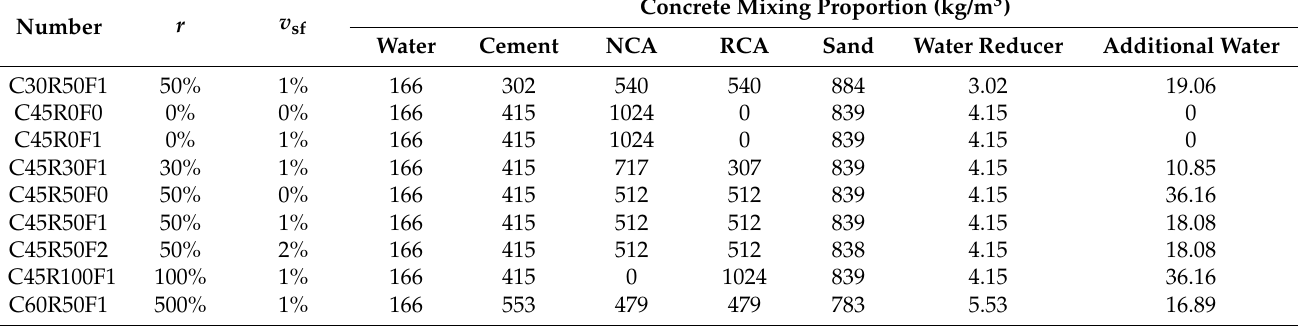
Table 3. Mixture proportions of